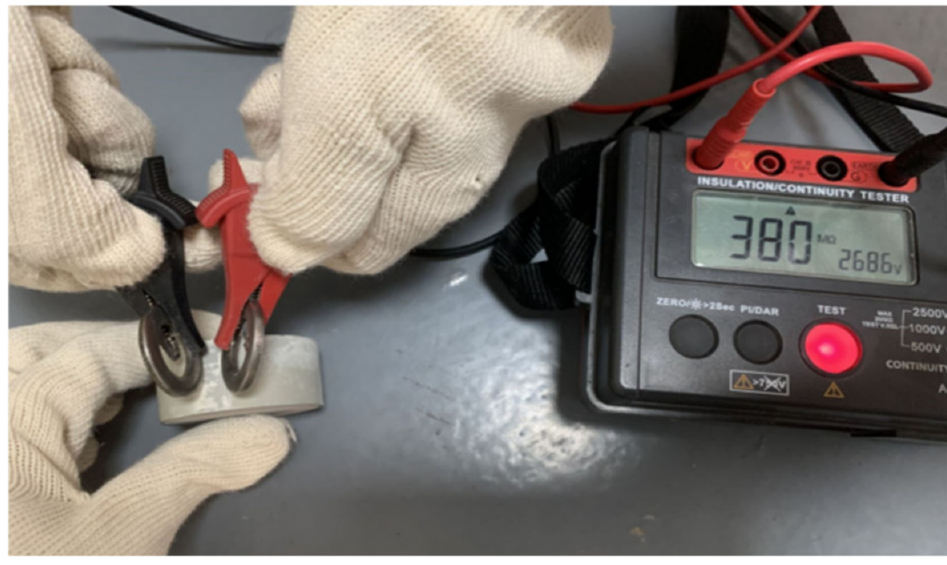
Figure 10. Insulation resistance test. Three test points are selected for the insulation resistance test of the varistor in each state, and the average value of the insulation resistance of each varistor is shown in Figure